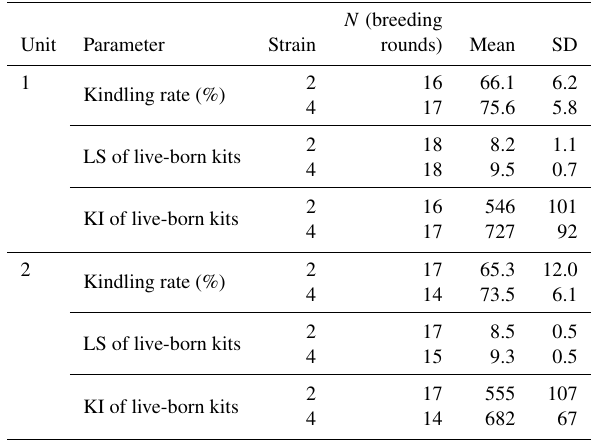
Table 1. Influence of genotype (strain) on reproductive parameters. Table 3. Influence of genotype (strain) on reproductive parameters – separated for both N (breeding